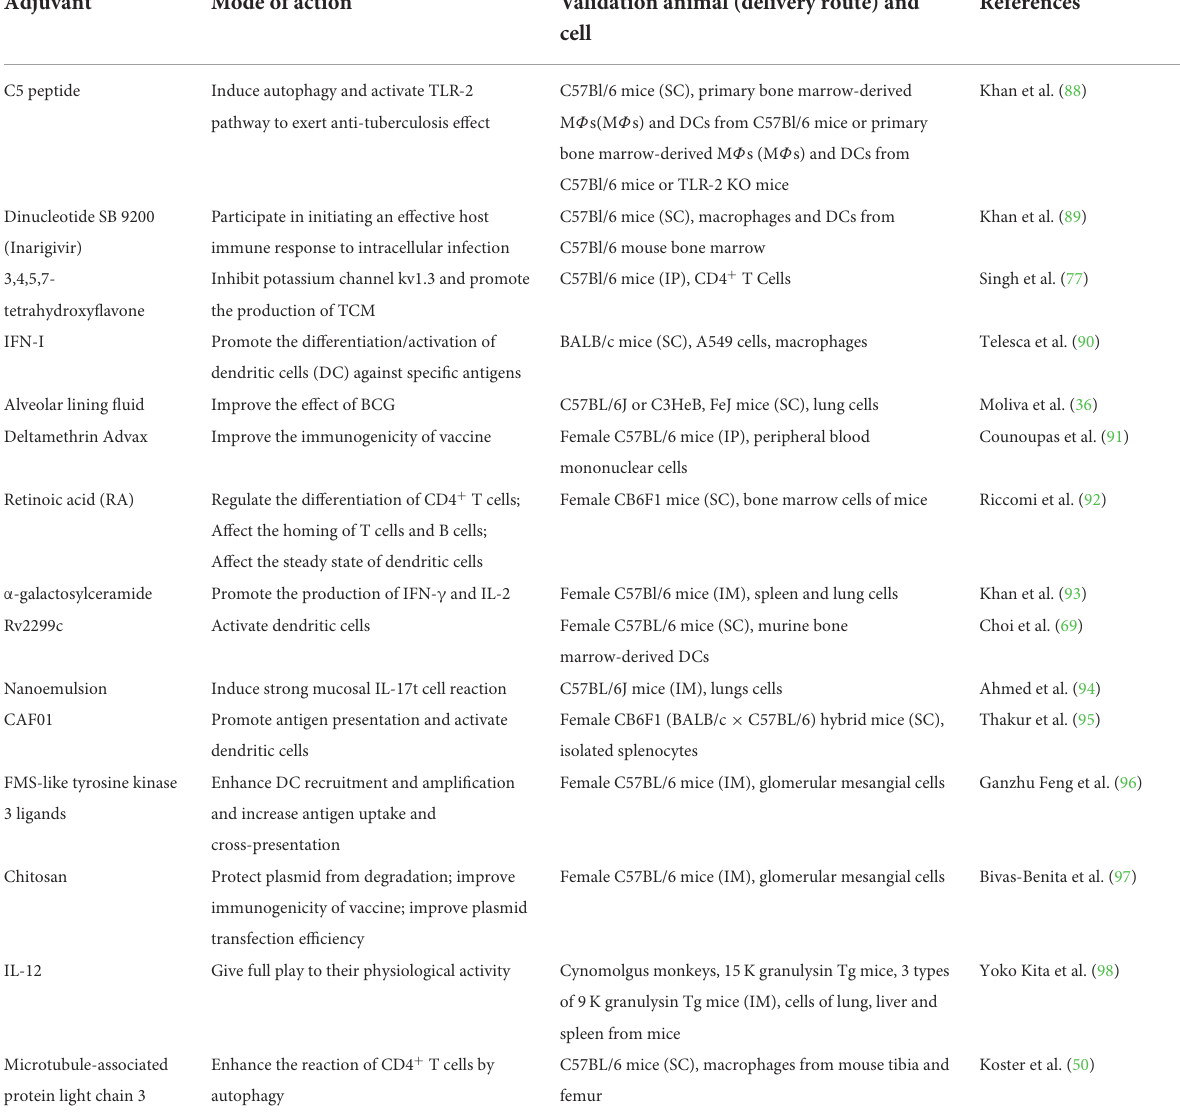
TABLE 1 Summary of adjuvants applied in tuberculosis